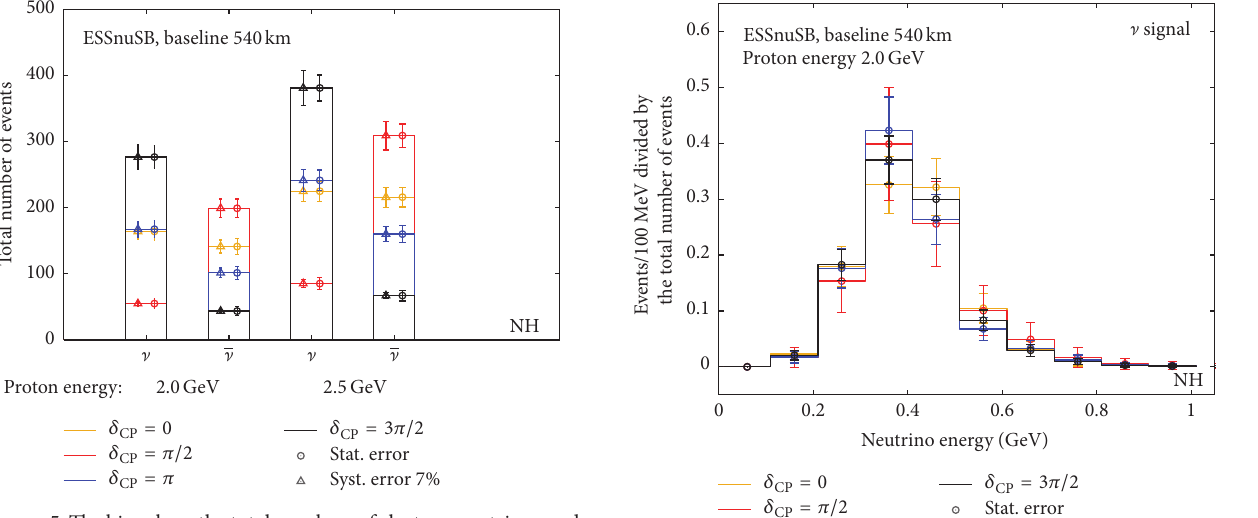
Figure 5: The bins show the total numbers of electron neutrinos and antineutrinos, respectively, detected in ESSnuSB after 2 years of data taking with a neutrino beam and 8 years with an antineutrino beam andforaprotonenergyof2.0 GeVandfor2.5 GeV,respectively,with the detector placed at the second maximum.